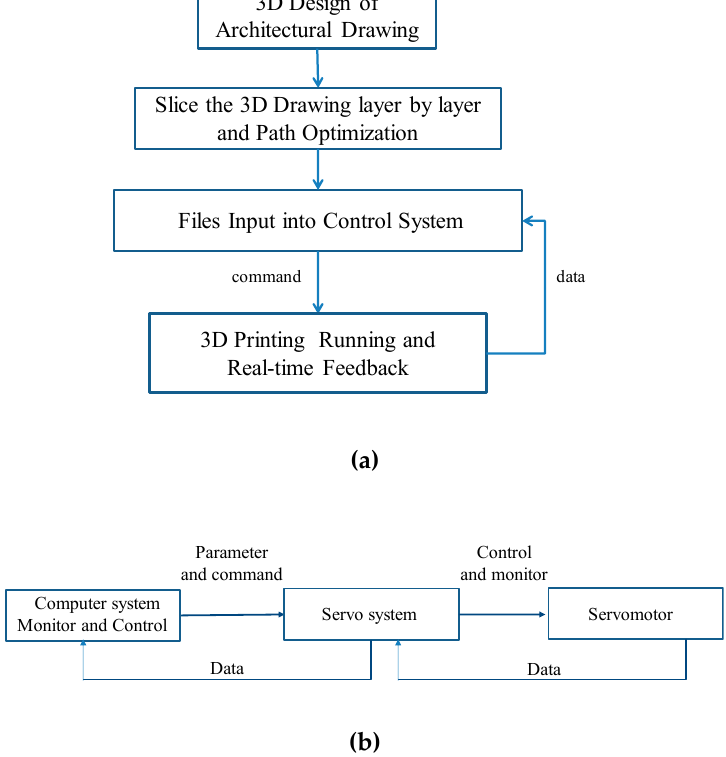
Figure 4. The software system ( a ) Running process for the software and ( b ) feedback control system.